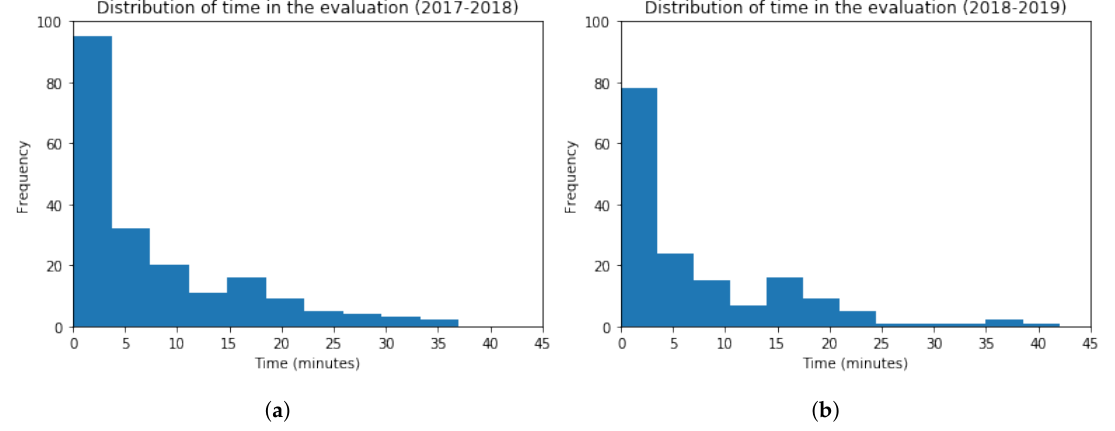
Figure 14. Histogram Graphs for the Time Spent in the Evaluation Resources. ( a ) 2017–2018 ( b ) 2018–2019.